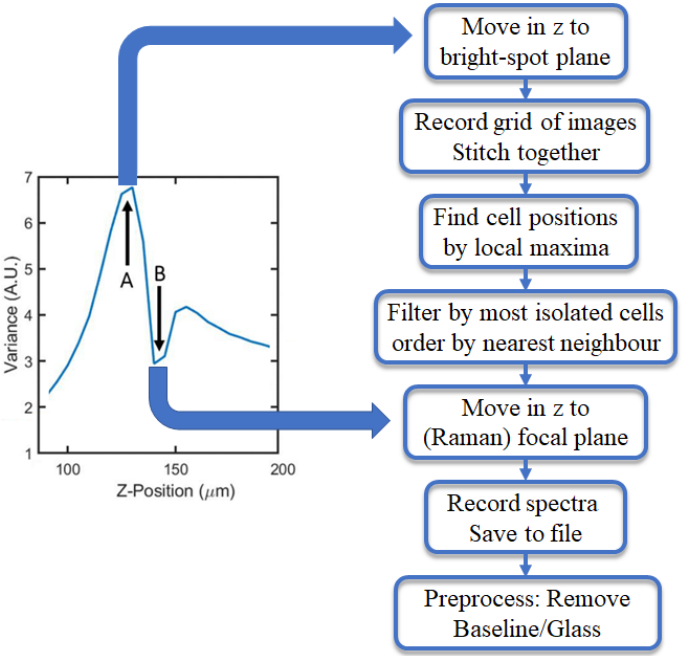
Figure 4. Variance profile shown on left side with points A and B corresponding to the sample positioned at the bright-spot plane and the focal plane of the microscope, respectively—corresponding to images shown in Figure 2a,c. On the right side, a high-level flow chart is shown for the overall automated Raman cytology process, which includes moving the sample between these two